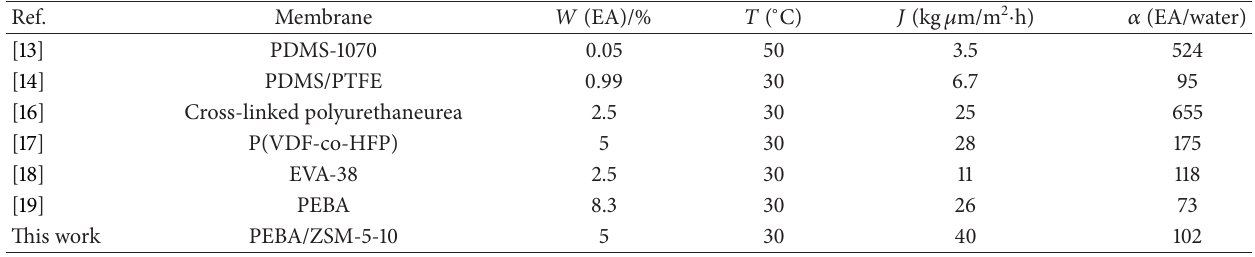
Table 2: Comparison of PV results of PEBA/ZSM-5-10 membrane for EA/water mixture with the literatures. Ref.